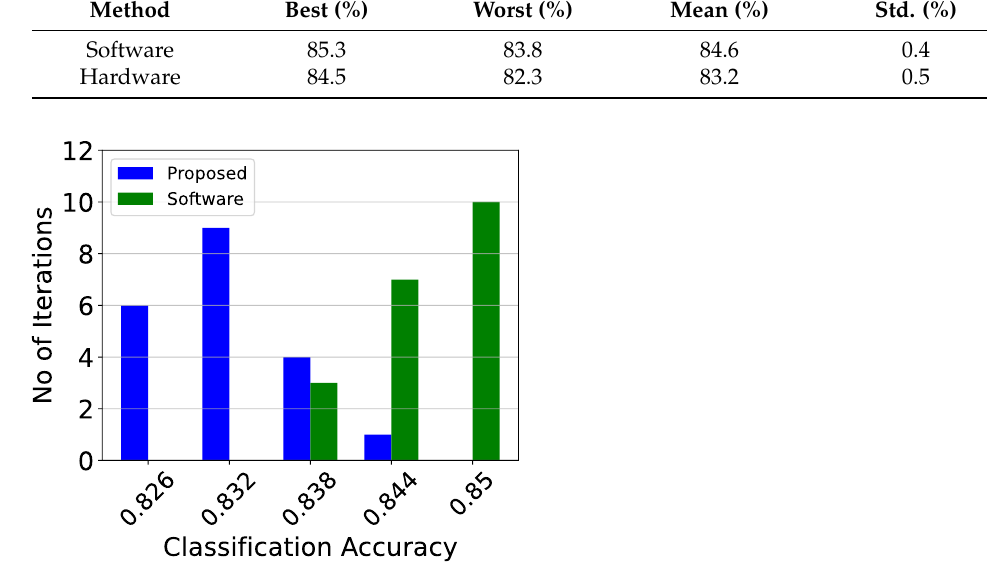
Figure 16. The classification results comparing the software and the proposed implementations for 20